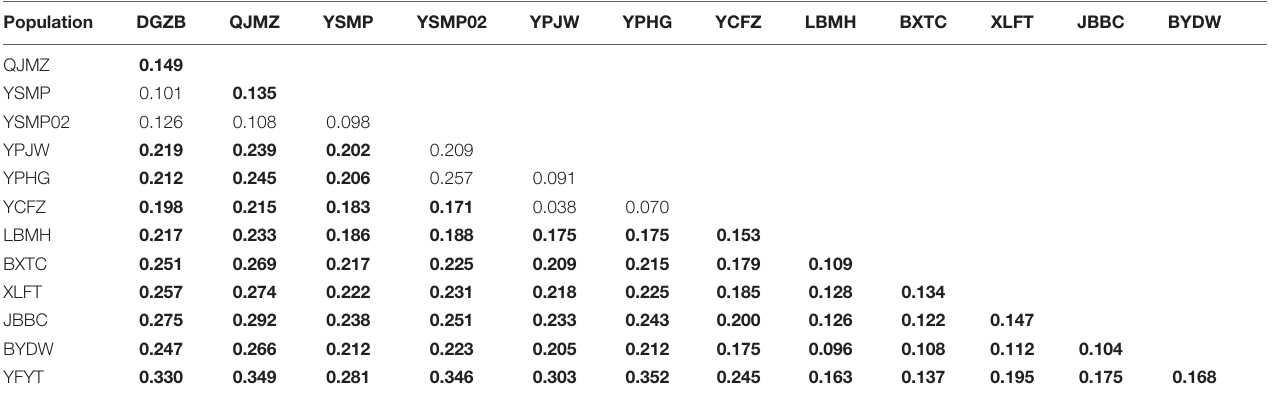
TABLE 2 | Pairwise F ST values among 13 populations of Amorphophallus albus based on 24,225 SNPs. Population DGZB QJMZ YSMP